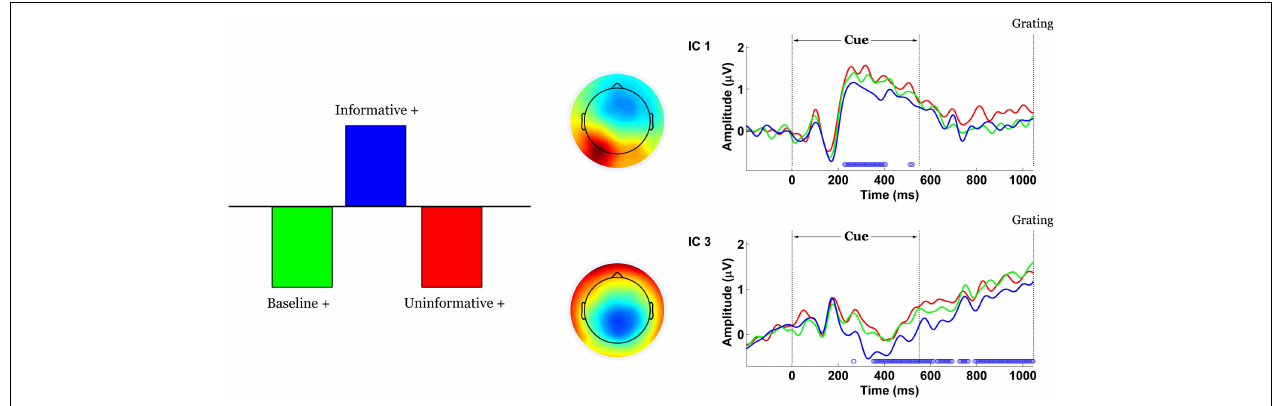
FIGURE 6 | Spatiotemporal patterns of scalp activity that differentiate Informative and Uninformative/Baseline conditions. Left: schematic indicates how the statistical contrast was coded. Middle: colour-coded topomaps indicate the weights in the ICA mixing matrix. Warmer colours